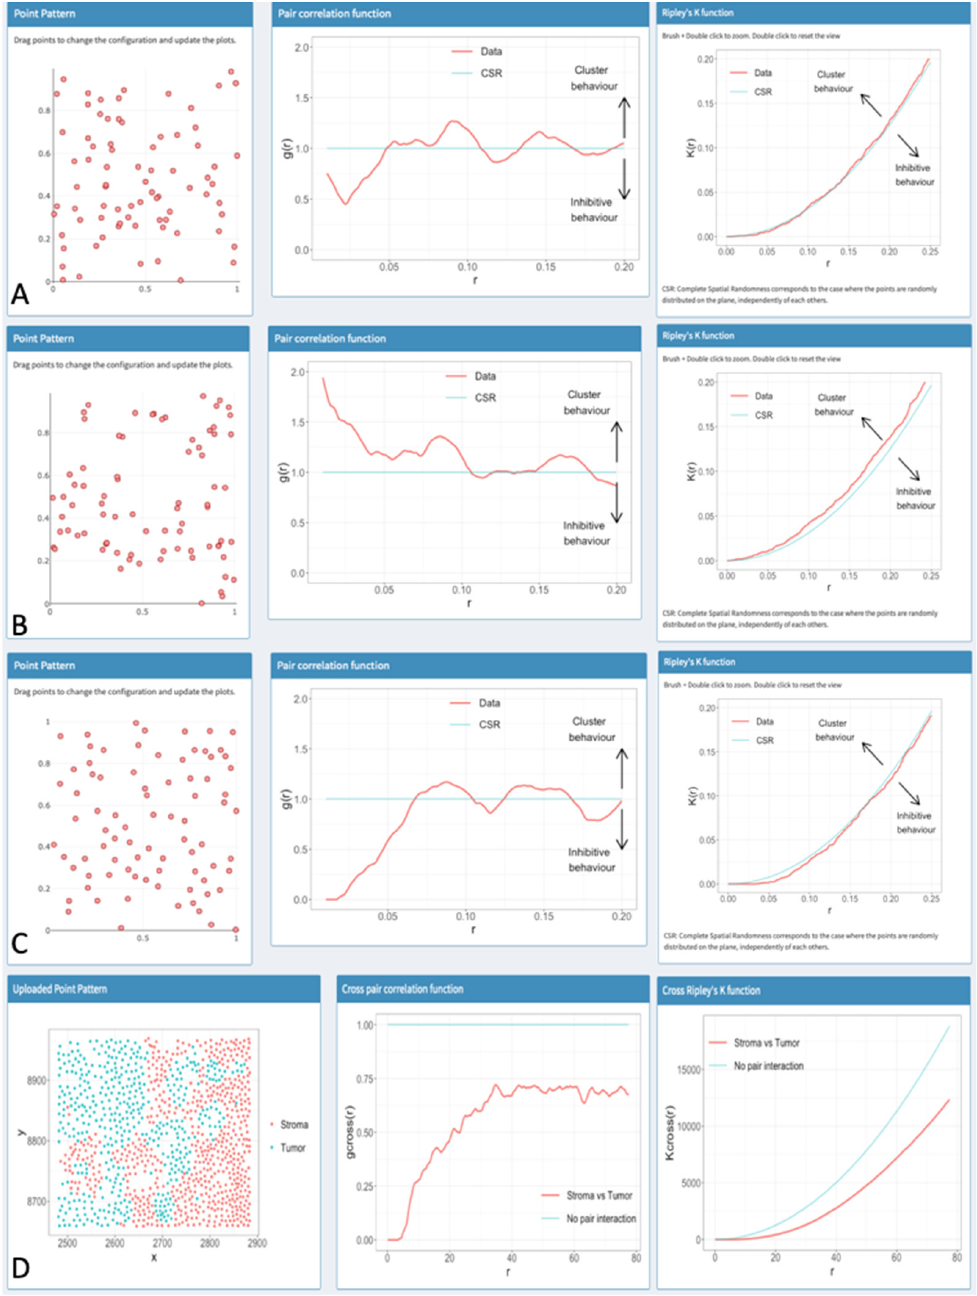
Figure 3. Exemplary pattern distributions and the corresponding K-function and pcf. All images in this figure were taken from the Shiny apps by C.A.N.B. and J.K. Lines corresponding to the computed functions are shown in red, while the lines corresponding to a Poisson distribution are shown in blue. ( A ) A randomly distributed pattern (Poisson distribution). While the pcf in the second column varies around the line of a theoretical Poisson distribution, the K-function of the pattern in the third column is very close to the line of a theoretical Poisson distribution, implying that the pattern might be close to complete spatial randomness (CSR). ( B ) A pattern with a clus- tering behavior. The corresponding pcf in the second column stays mostly above the pcf of a theo- retical Poisson distribution, as does the K-function in the third column. This implies a clustering behavior. ( C ) A pattern with inhibitive behavior. The corresponding pcf in the second column stays mostly below the pcf of CSR. The K-function in the third column is below the line of CSR as well, which implies an inhibitive or regular behavior. ( D ) An exemplary dataset of the second app where tumor (blue points) and stroma (red points) cells were differentiated. Instead of the K-function and pcf used before, their Cross-functions are being used. Here one can clearly see an inhibitive or avoiding pattern where cells of one type are mostly close to each other while avoiding close contact